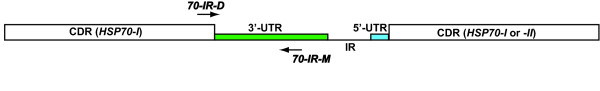
Schematic map of theLeishmania HSP70locus (fragment), showing the region amplified in this study. The map was drawn to scale [39]. PCR primer annealing sites are indicated by arrows. CDR, protein coding region; 5’- and 3’-UTR, untranslated regions; IR, intergenic region.